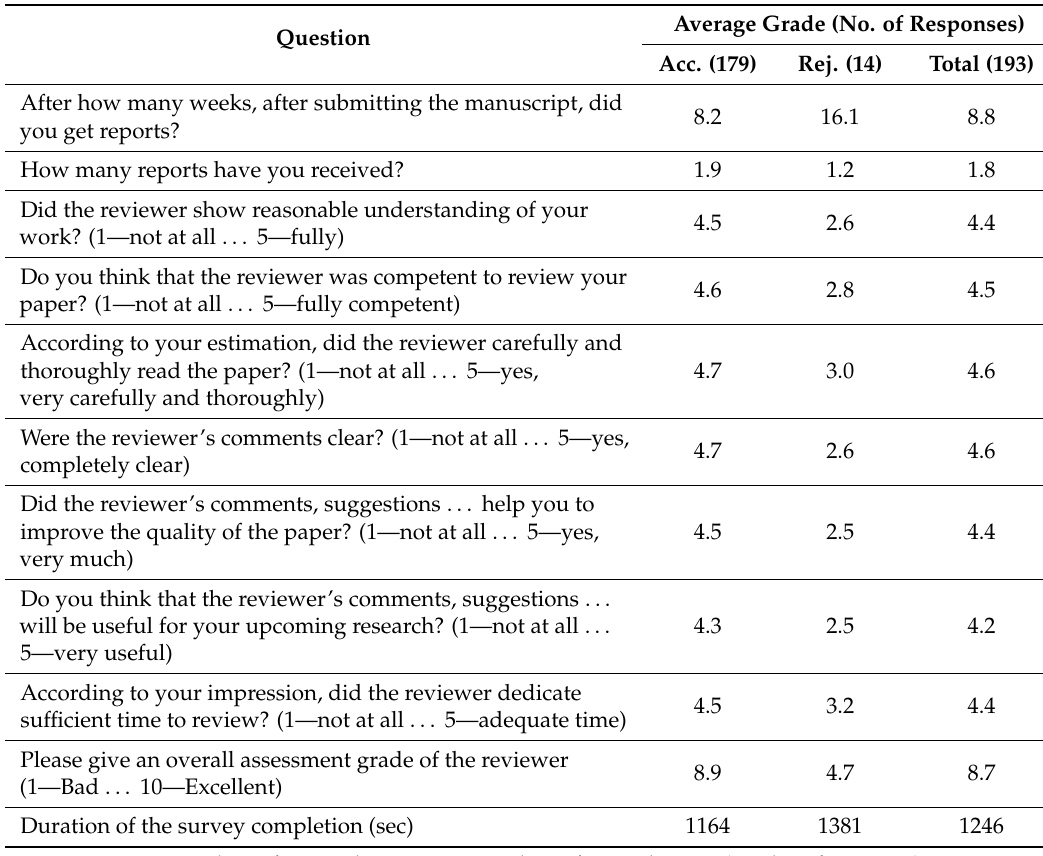
Table 2. Average grades which authors gave as a response to specific